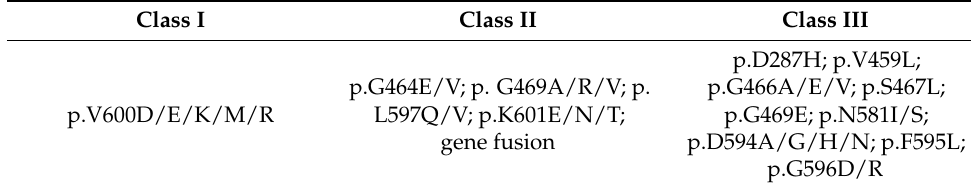
Table 1. BRAF mutations